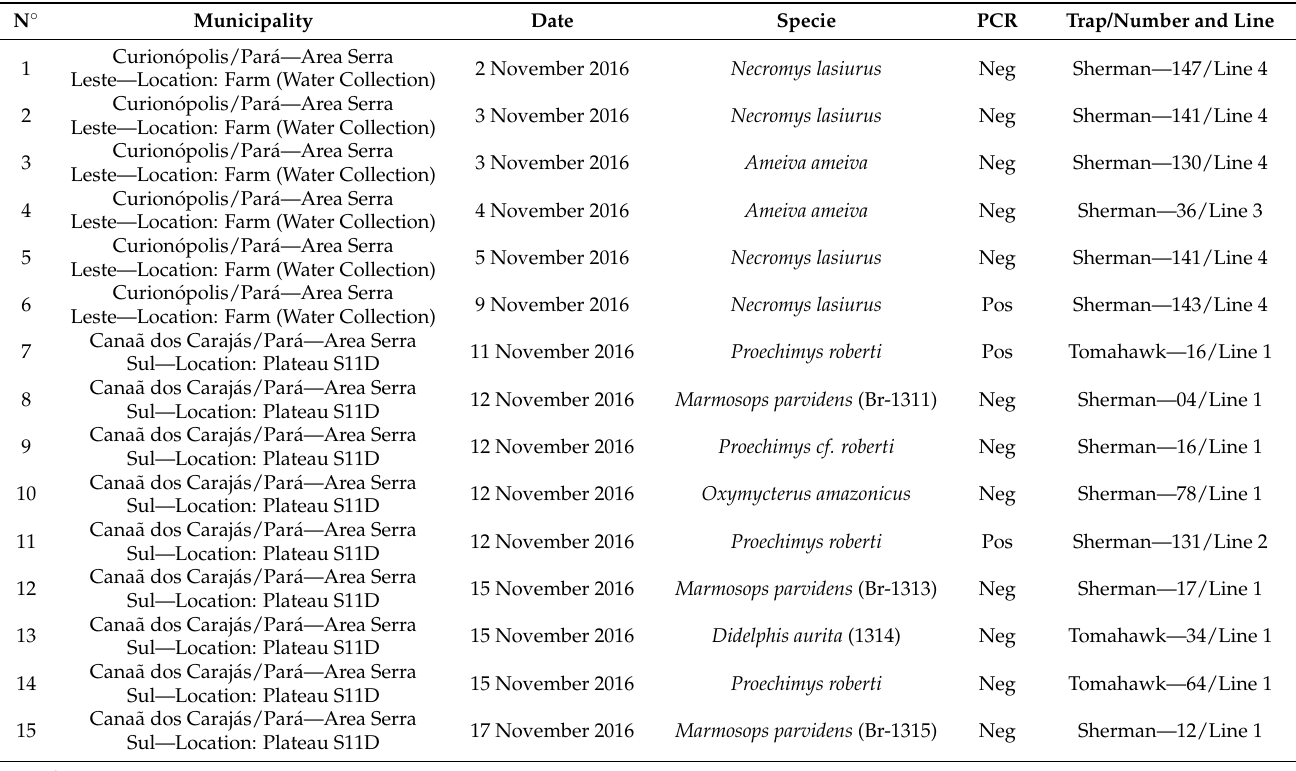
Table 1. Animals’ information according to capture